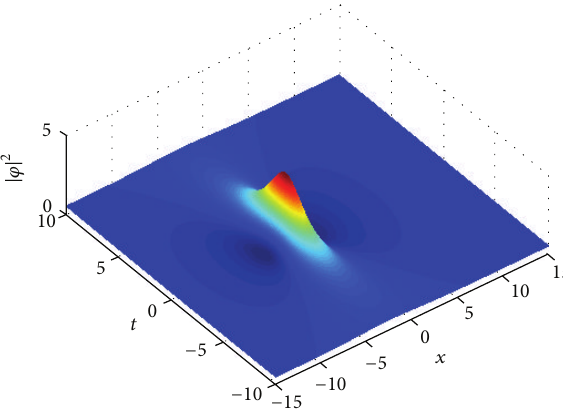
Figure 1: The first-order rogue wave propagations for the intensity |𝜑| 2 with the gravity field 𝑏 = 0.5 .